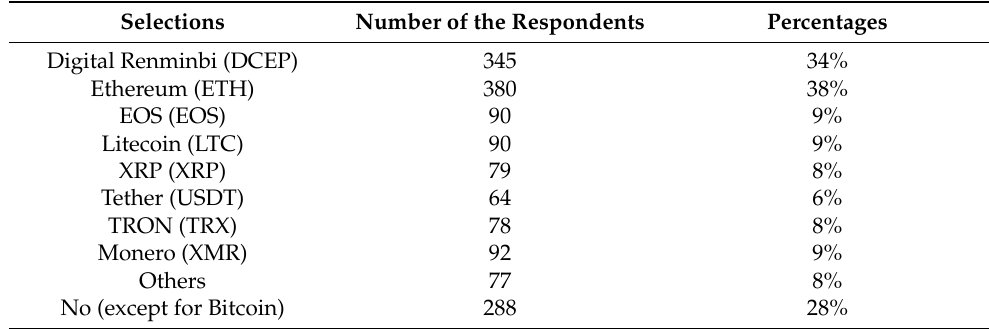
Table A8. Which cryptocurrency have you already learned (multiple-choice question)?